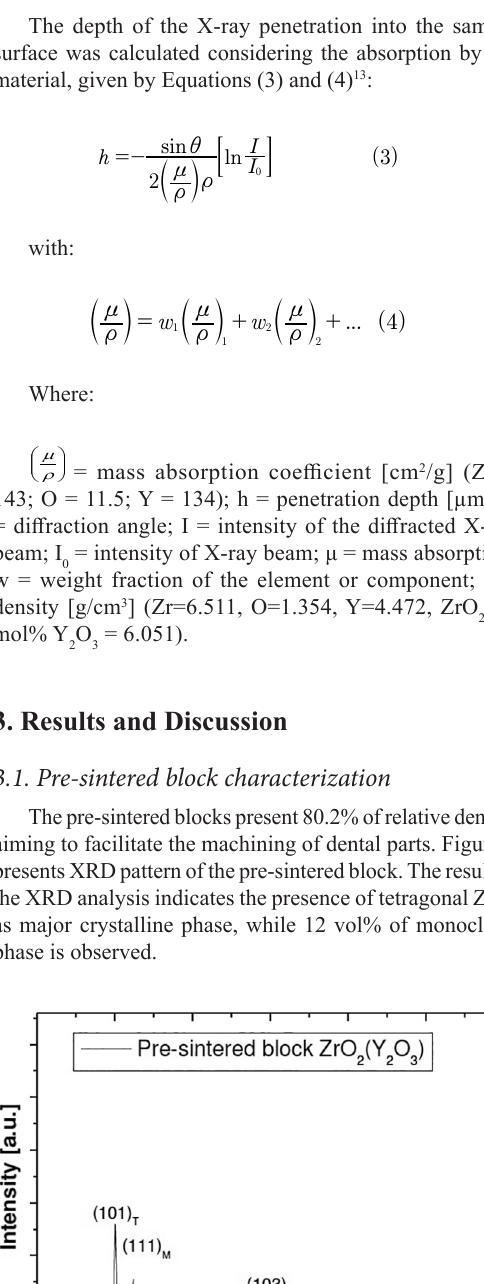
Figure 1: XRD pattern of the pre-sintered ZrO